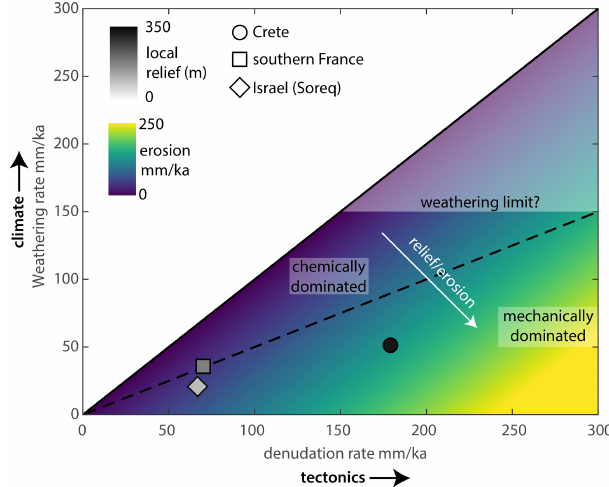
Figure 6. Mean weathering versus mean denudation rates for the sites with alluvial denudation data. The dashed line is the 1 : 1 ratio of weathering and erosion. Weathering-dominated landscapes will tend to be subdued; high erosion rates will lead to high relief areas dominated by slope-dependent mechanical